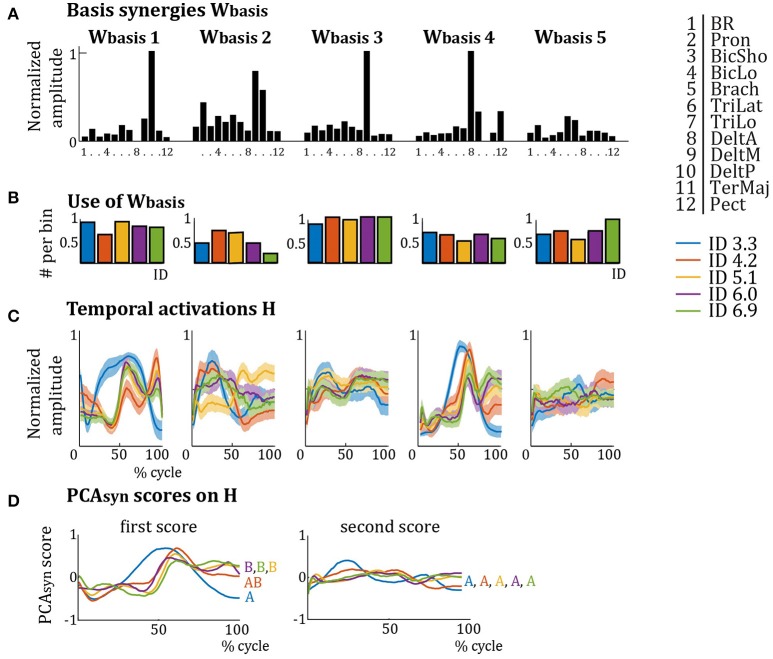
(A) Synergy weights from Figure 3 averaged per cluster (Wbasis). Per basis synergy, the normalized weight of each of the 12 muscles is represented. Higher bars indicate increased weight. (B) Normalized frequency of use of the basis synergies per ID. (C) Average temporal activation components over a movement cycle per basis synergy per ID. Darker colors represent lower IDs. (D) First and second PCAsyn scores on the temporal activations H of (B). The first PCAsyn score shows a clear difference between the activations of the IDs, activations with significant correlations (p << 0.001) are grouped by letters (A,B), whereas the second PCAsyn score does not (all activations are correlated with all others).